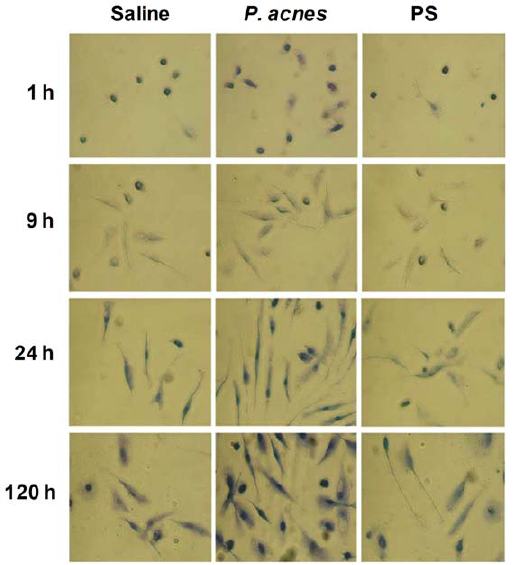
Figure 4. Differentiation of B-1b cells into B-1 cell-derived phagocytes (B-1CDP). The peritoneal cells from mice treated with P. acnes , PS or saline (control group) were cultured for 5 days. The non- adherent cells were re-cultured on cover glasses for 1 to 120 hours for phagocyte differentiation. The cells that adhered to the cover glasses were then fixed, stained with Giemsa and analyzed using optical microscopy. Magnification 500 6 .